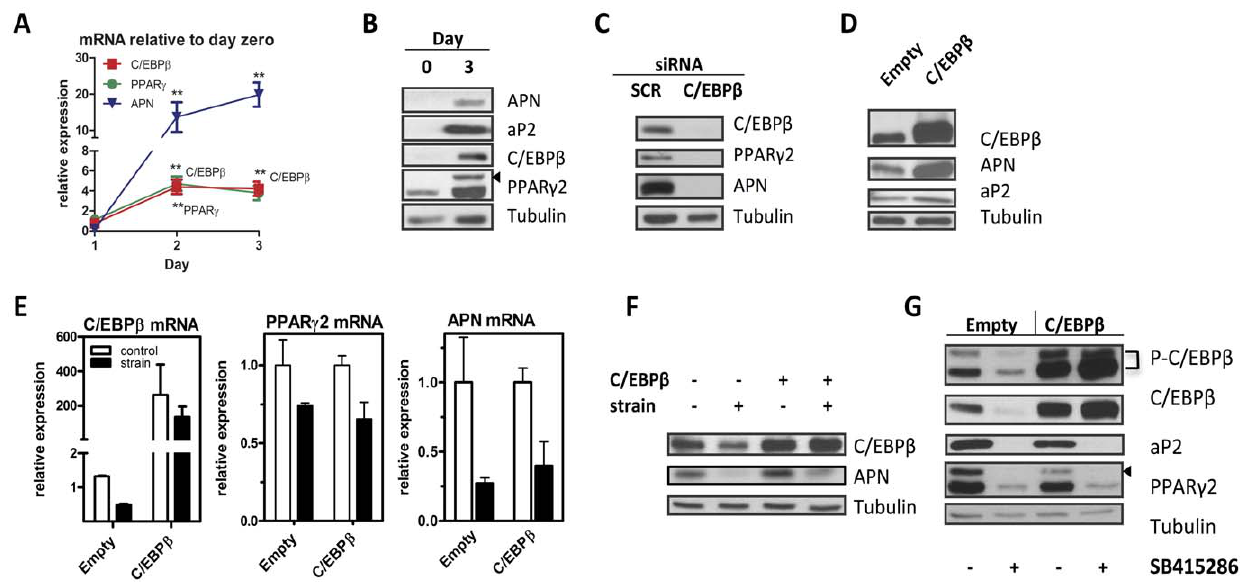
Figure 2. C/EBP b overexpression does not rescue adipogenesis from mechanical inhibition. A, C3H10T1/2 cells cultured in adipogenic media and analyzed on indicated days by real time PCR for C/EBP b , PPAR c , and adiponectin (APN) n=3, **p , 0.01 relative to day zero B, C3H10T1/2 cells cultured in adipogenic media and blotted for C/EBP b , markers of adipogenesis. C, Immunoblot of C3H10T1/2 cells transfected with siRNA to C/ EBP b . 24 hours after transfection, adipogenic medium was added for 72 hours. D, C3H10T1/2 cells were transfected with 1 m g of overexpression vector for C/EBP b or control empty vector. 24 later adipogenic media was added and cells were analyzed at 48 hours by immunoblot for C/EBP b , adiponectin (APN) or aP2. E, C3H10T1/2 cells overexpressing C/EBP b as in A were subjected to strain for 3 days and analyzed by real-time PCR for C/ EBP b , PPAR c 2 and adiponectin mRNA expression. F, experiment as described in (E) analyzed by immunoblot. G, C3H10T1/2 cells were transiently transected with a C/EBP b overexpression vector. 24 hours later adipogenic media + / 2 SB41528 was added and maintained for 3 days prior to protein analysis for markers of adipogenesis and C/EBP b .